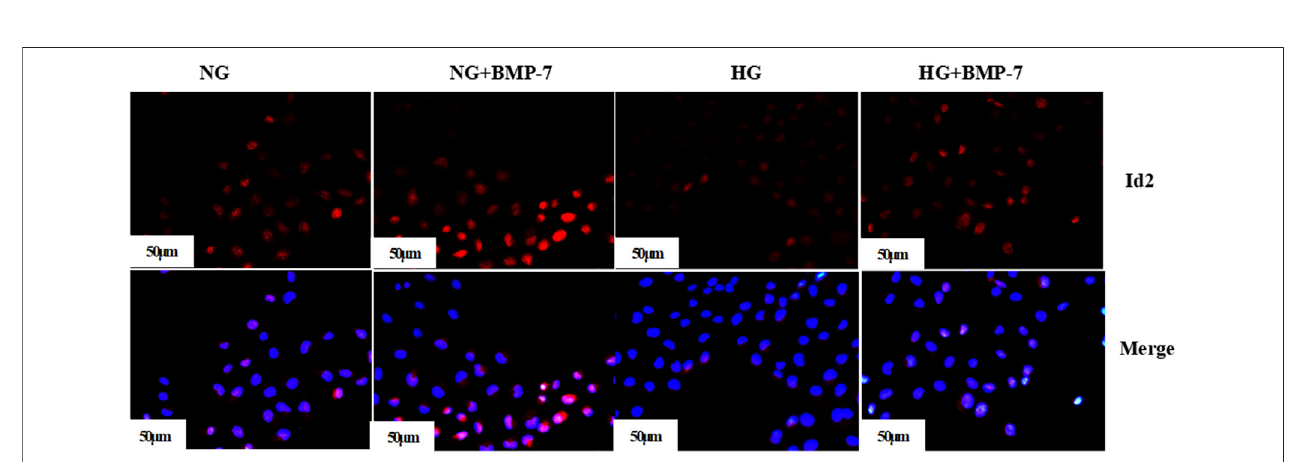
FIGURE 7 | The expression of Id2 in cells was detected by immuno fl uorescence (scale bar is 50 μ m).